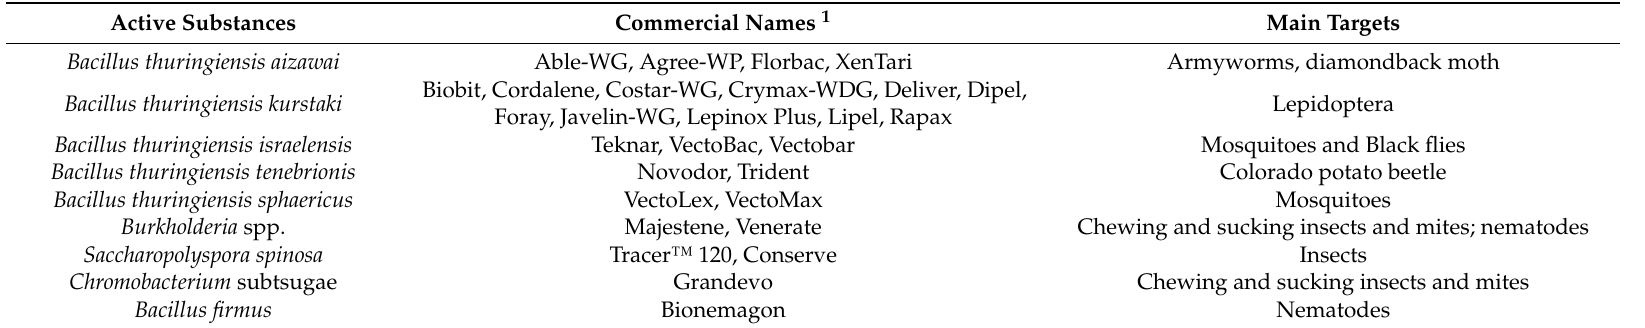
Table 1. Selection of commercial products based on entomopathogenic